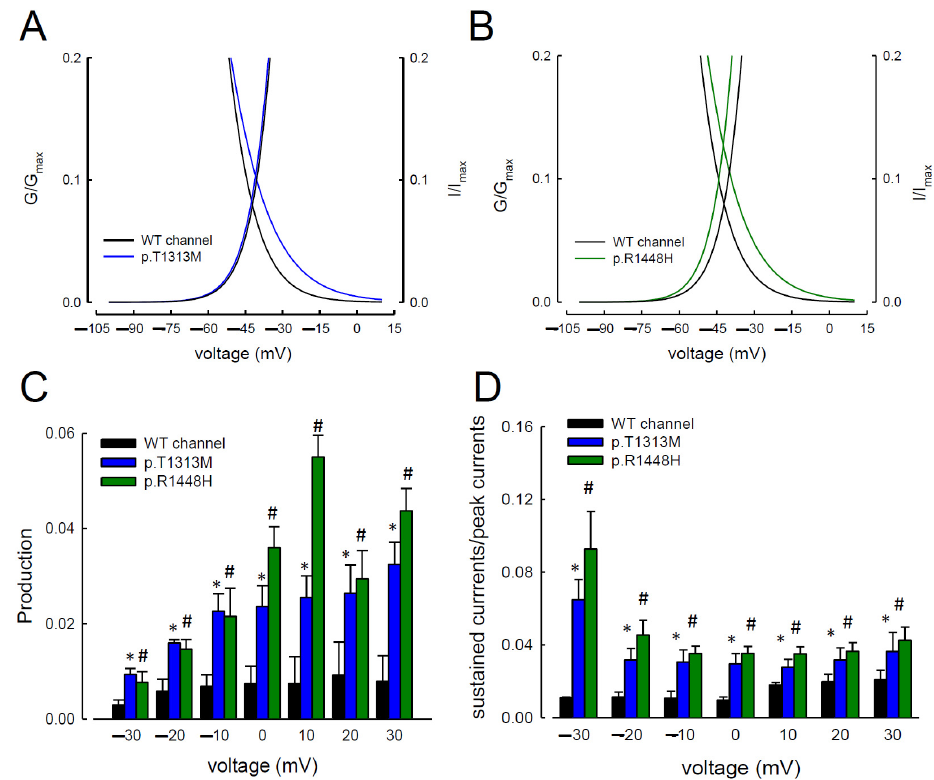
Figure 2. Extensive Window Currents in the p.T1313M and p.R1448H Mutant Channels. ( A , B ) The black (WT) and colored (p.T1313M, blue; p.R1448H, green) fitted lines represent a closer view of the activation and inactivation curves shown in Figure 1B between − 100 and +10 mV in the WT, p.T1313M, and p.R1448H mutant Na v 1.4 channels. ( C ) The production of G/G max and I/I max from Figure 2A,B are plotted against the specific voltage at − 30 to +30 mV in the WT, p.T133M, and p.R1448H mutant Na v 1.4 channels (* and #, p < 0.05). ( D ) The ratio between the sustained (the average currents between 85 and 90 ms of the pulse) and maximal (peak) transient Na + currents at +30 to − 30 mV (see Figure 1A for the sample sweeps) was significantly larger in the p.T1313M and p.R1448H channels than in the WT Na v 1.4 channels (* and #, p < 0.05).